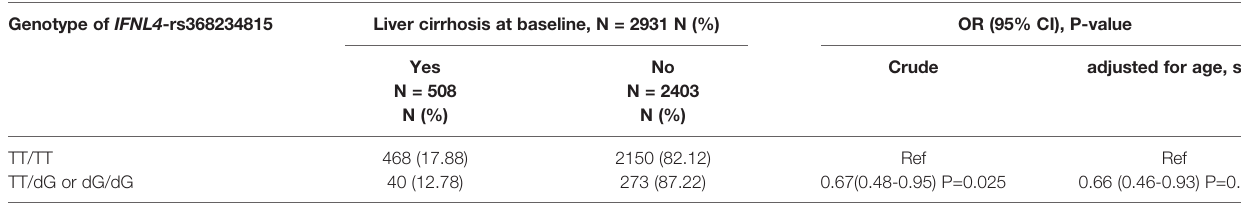
TABLE 6 | Prevalence of cirrhosis in HCV-infected patients in relation to IFNL4 genotype in the REVEAL II cohort, Taiwan. Genotype of IFNL4 -rs368234815 Liver cirrhosis at baseline, N = 2931 N (%)